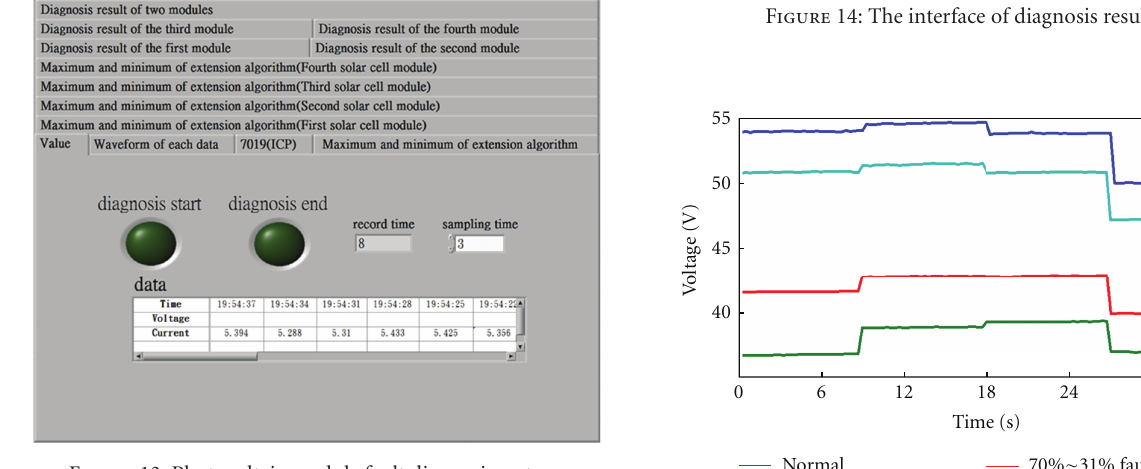
Figure 13: Photovoltaic module fault diagnosis system.